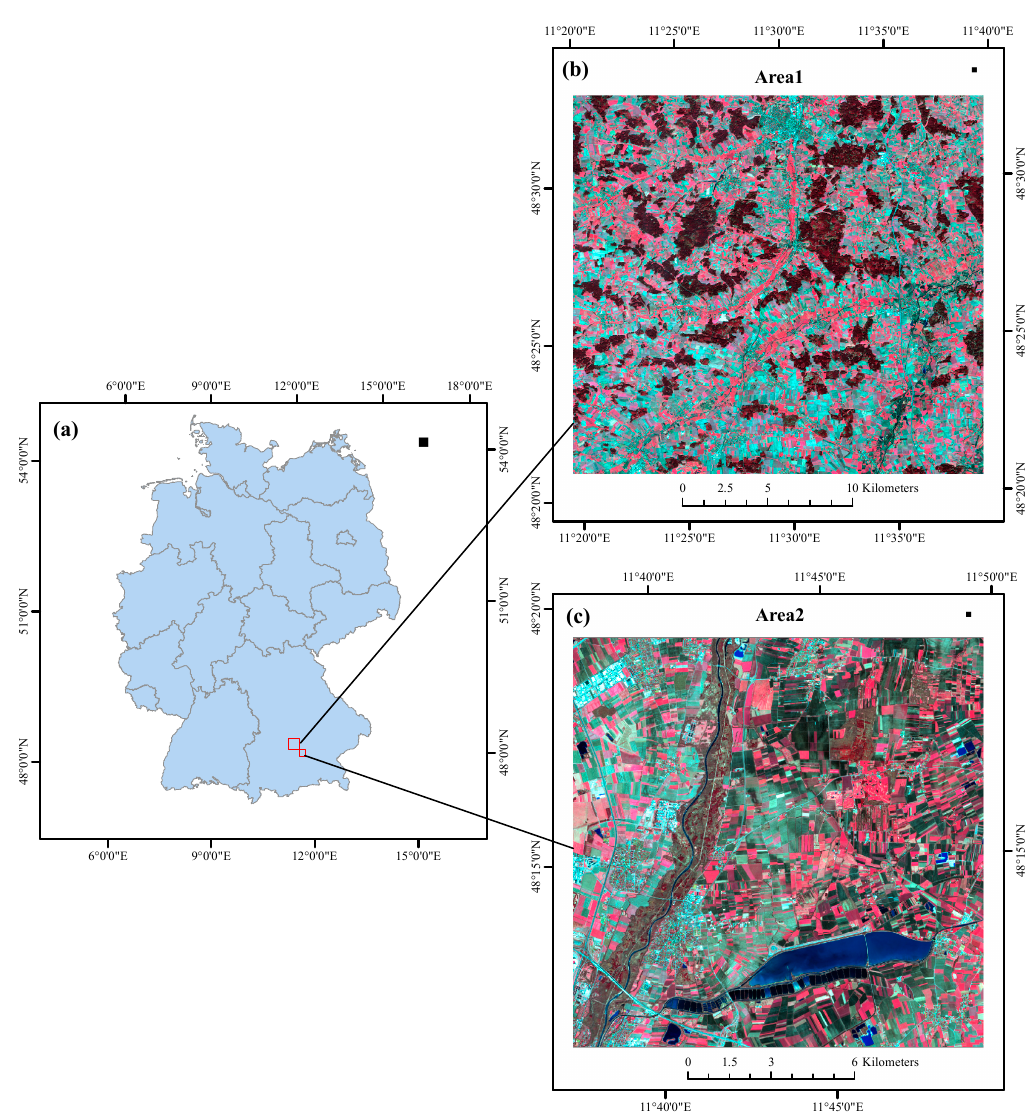
Figure 1. Study area. ( a ) Map of Germany; ( b ) images of Study Area 1; and ( c ) images of Study Area 2.